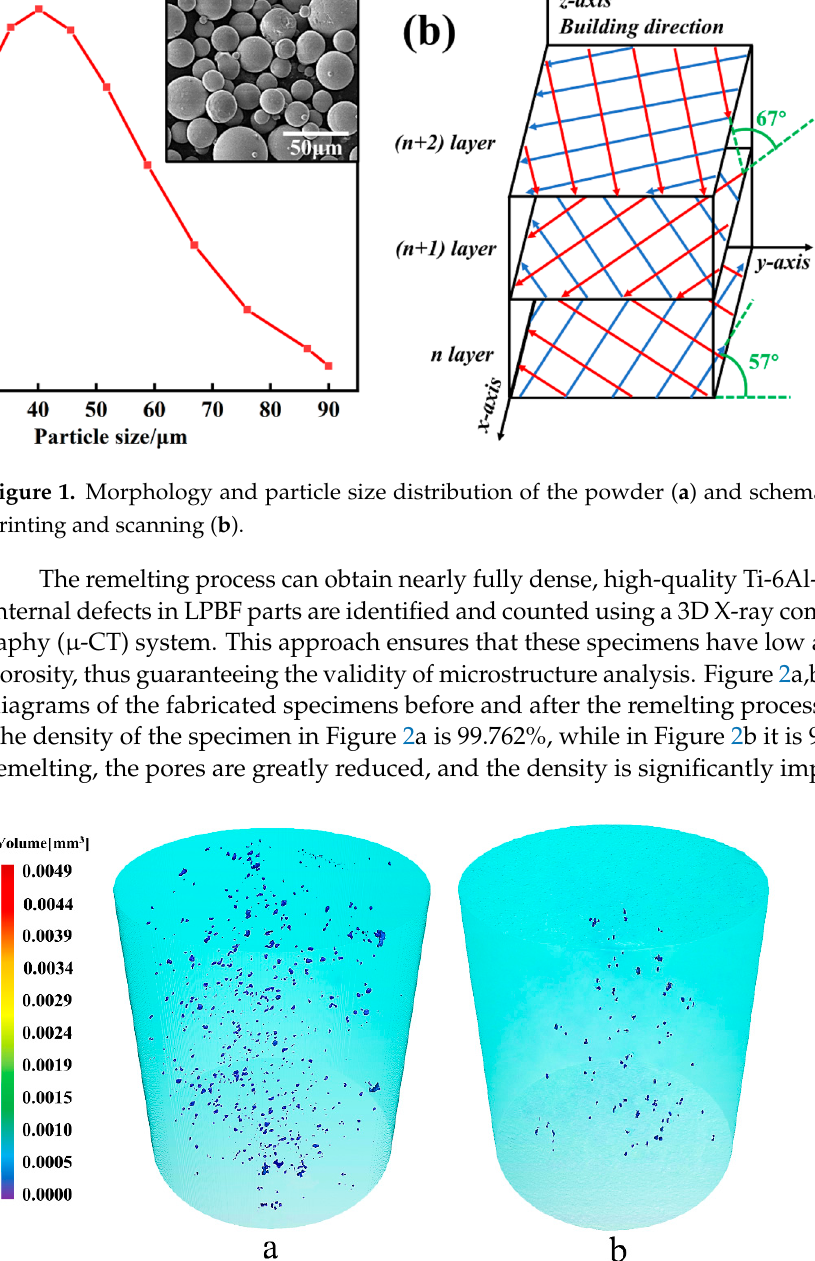
Table 1. Chemical composition of Ti-6Al-4V alloy powder (wt.%).